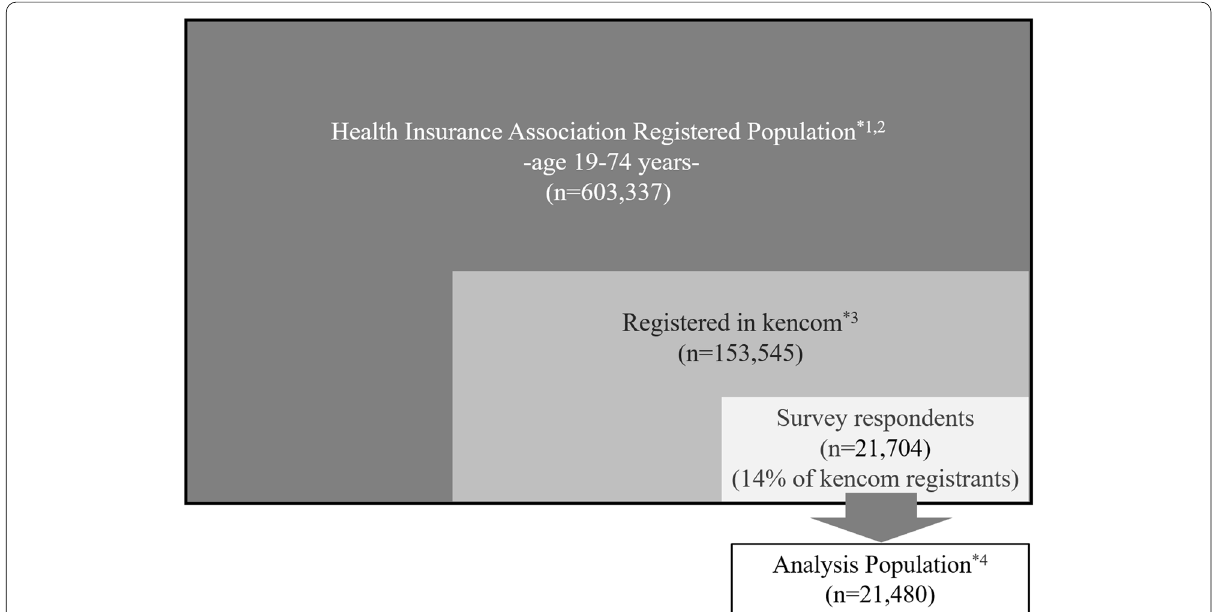
Fig. 1 Description of the study population. * 1 Insured: Insured persons and their dependents. * 2 Persons in the population that have registered information and claims information if they have visited medical institution. * 3 Survey responses, claims information, and registration information can be merged with registered ID. * 4 Among 21,704 survey respondents, 21,480 people were included in the analysis population. A total of 224 respondents were excluded from the analysis population as their age and gender did not match the claims